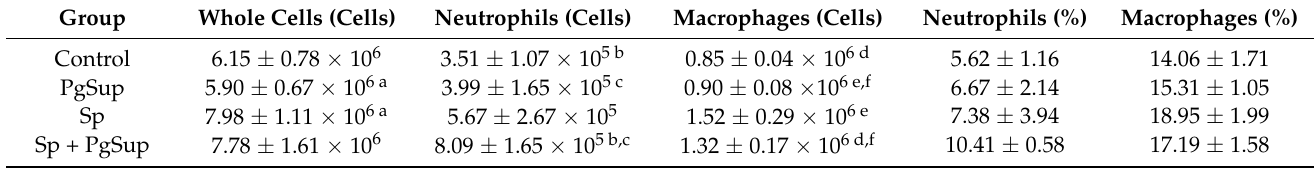
Table 1. The absolute number and frequency of neutrophils and macrophages in the lung after administration. Mice were administrated with sTSB, PgSup, Sp, or Sp-PgSup mixed. After 24 h, the whole cells of the lungs were counted by microscopy and then the number of the lung infiltrating cells calculated after being analyzed by flow cytometry. The same superscript within the column indicates that there is a significant difference among treatments ( p < 0.05, t -test). Group Whole Cells (Cells) Neutrophils (Cells) Macrophages (Cells)